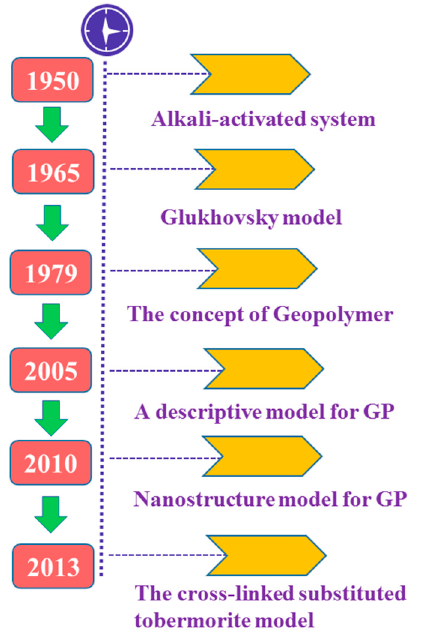
Figure 1. Development history of geopolymers.